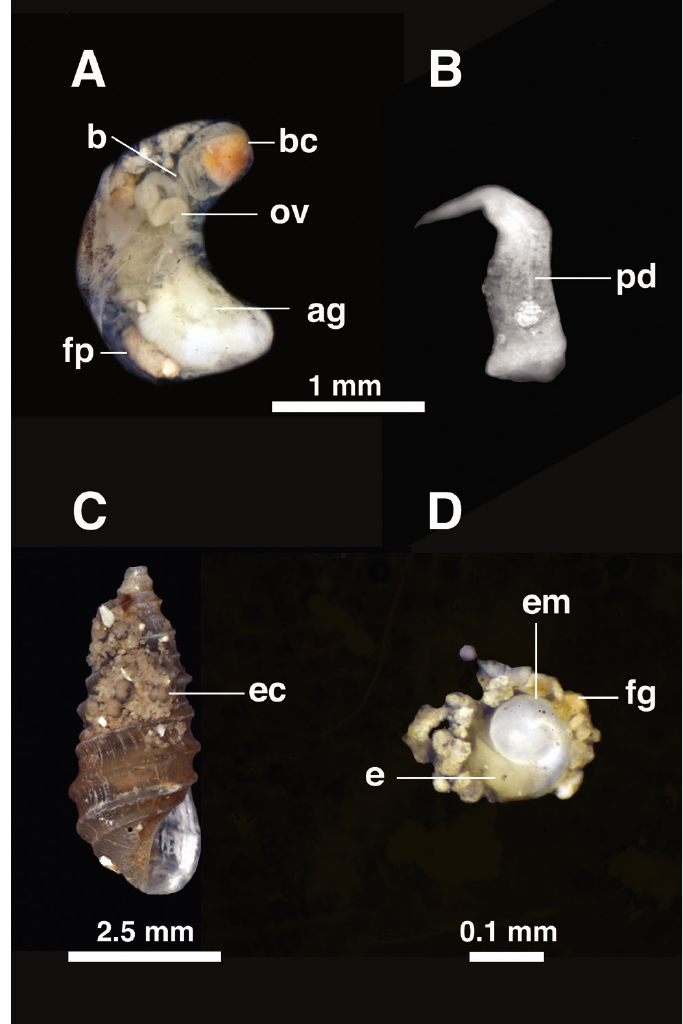
Figure 6. Genital anatomy and egg capsules of Dianella schlickumi . A Female genitalia B Penis C Shell bearing egg capsules covered by fine-grained material D Egg capsule with embryo. Abbreviations: ag– albumen gland; b–beak-shape dilatation of the oviduct; bc–bursa copulatrix; fp–faecal pellets; fg–fine- grained material; e–eye; ec–egg capsules; em–embryo; ov: renal oviduct; pd–penial